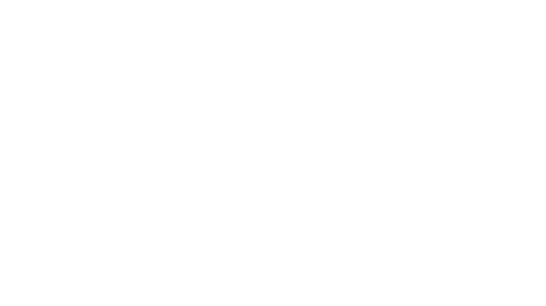
Table 3. Prediction CD spectroscopy of recombinant proteins.